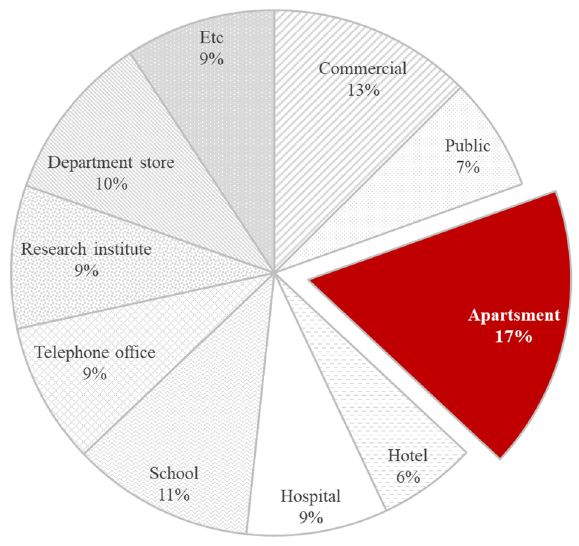
Figure 1. End-use energy statistics for buildings.